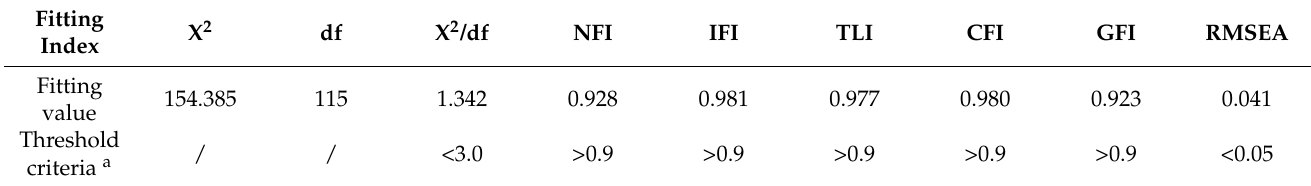
Table 13. The overall fitness of the second-order structural equation